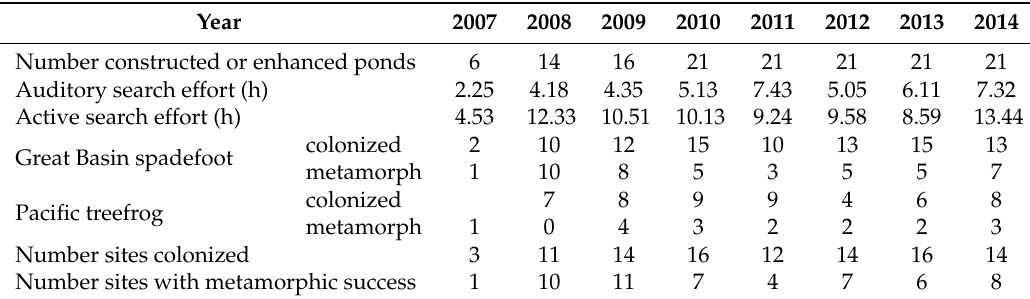
Table 2. Annual search effort, colonization (presence of any life stage), and metamorphic emergence of amphibian species utilizing constructed and enhanced pond sites (2007 to 2014). Excludes two records of metamorphic Columbia spotted frogs (site # 1) presumed to have immigrated from known nearby breeding